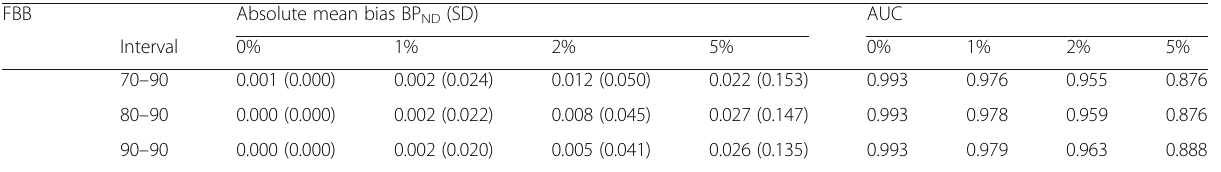
Table 6 Absolute bias in BP ND and AUC as a result of noise and the dual-time-window protocol for SRTM-generated